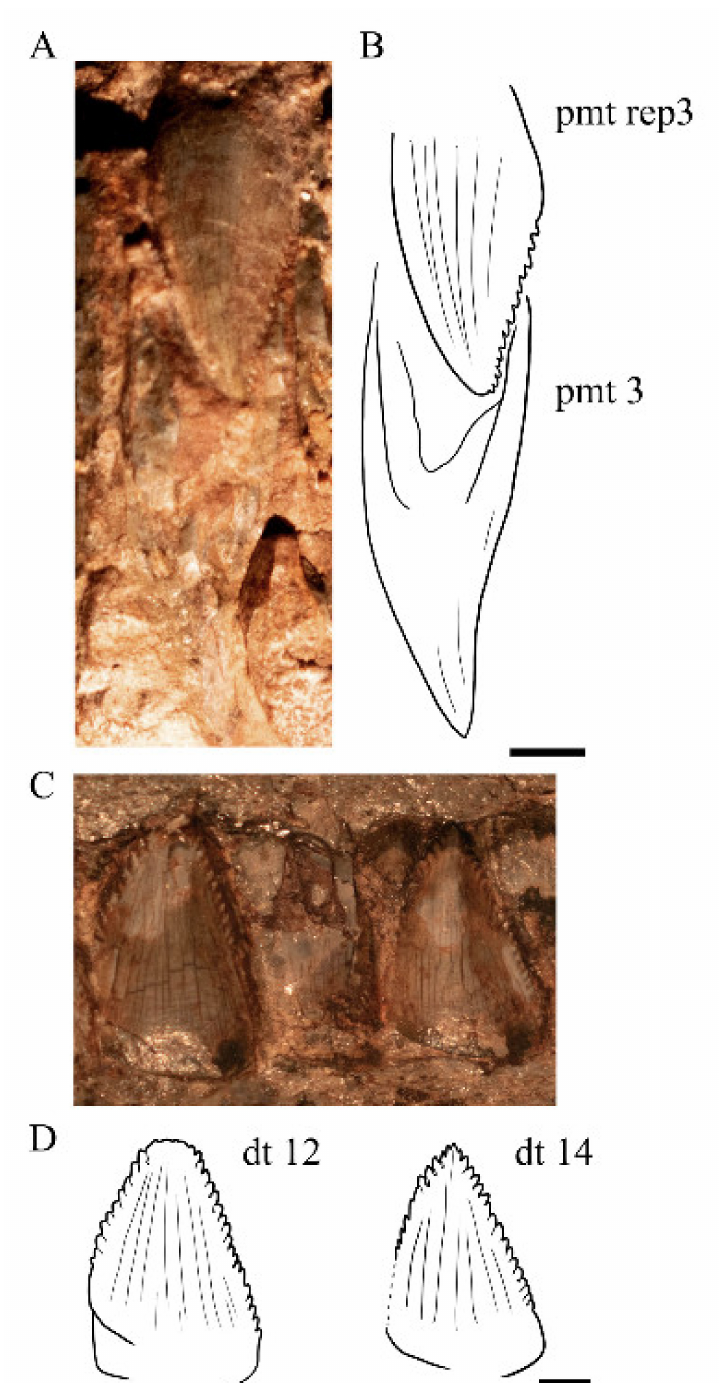
Figure 33. Photograph and schematic drawing of the teeth of NHMD 164741 and NHMD 164758. ( A ) Photograph of the left premaxillary teeth of NHMD 164758 in labial view. ( B ) Schematic drawing of the left premaxillary teeth of NHMD 164758 in labial view. ( C ) Photograph of the left dentary teeth 12 to 14 of NHMD 164741 in labial view. ( D ) Schematic drawing of the left dentary teeth 12 to 14 of NHMD 164741 in labial view. Abbreviations: dt, dentary tooth; pmt, premaxillary tooth. The numbers indicate the tooth position. Scale bar = 2